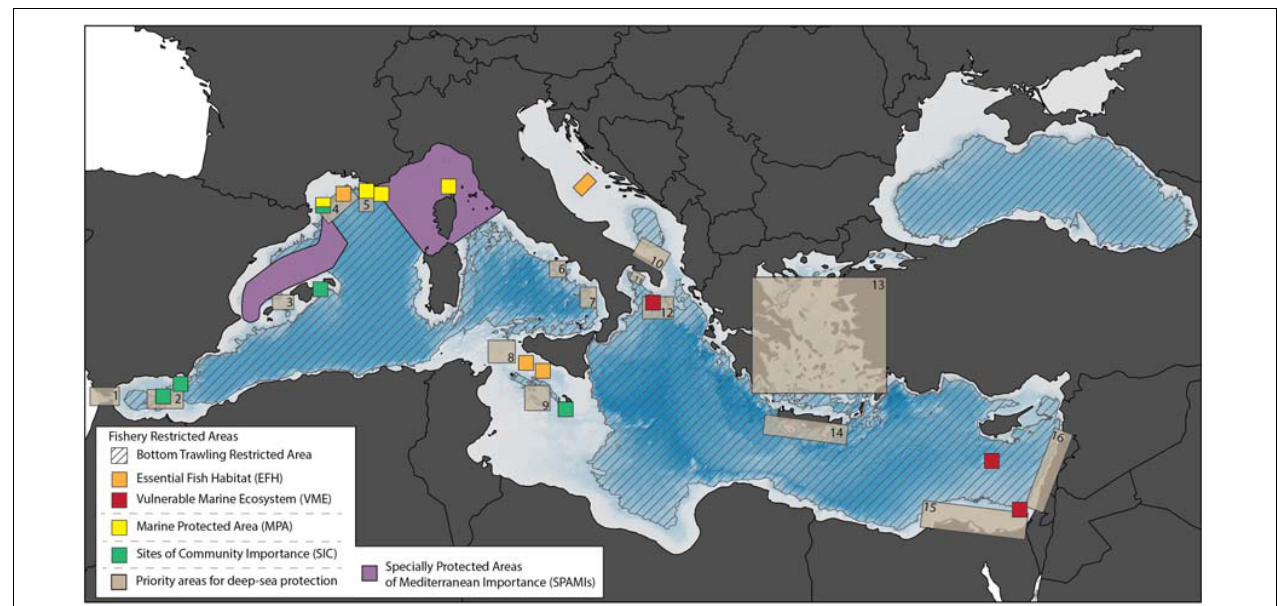
FIGURE 5 | Map of the Mediterranean deep-sea areas already under management measures and those identified as priority for conservation actions through the present work. Numbers on light brown rectangles indicate the areas identified, specifically 1. Strait of Gibraltar; 2. Alborán Sea; 3. Eivissa and Mallorca channels; 4. Canyon systems of the western Gulf of Lion and north Catalan margin; 5. Cassidaigne Canyon; 6. Dohrn Canyon; 7. Calabrian canyon system; 8 and 9. Deep basins of the Sicilian Channel; 10. Bari Canyon; 11. Apulian deep-sea bottoms, including the Bari Canyon; 12. CWC habitats of Santa Maria di Leuca; 13. Deep bottoms of the Aegean Sea; 14. Hellenic Trench south of Crete Island; 15. Deep Nile Delta Fan; 16. East Levantine canyons. VME areas banned to fishery, seamounts, and other similar features, and other fishery management measures from the FAO VME database (accessed January